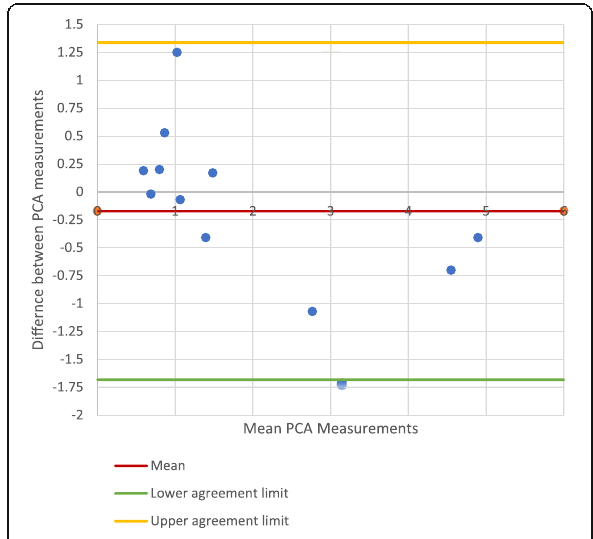
Fig. 9 PCA Measurements on anatomical axis CT scanning: best-fit vs . multl-slice